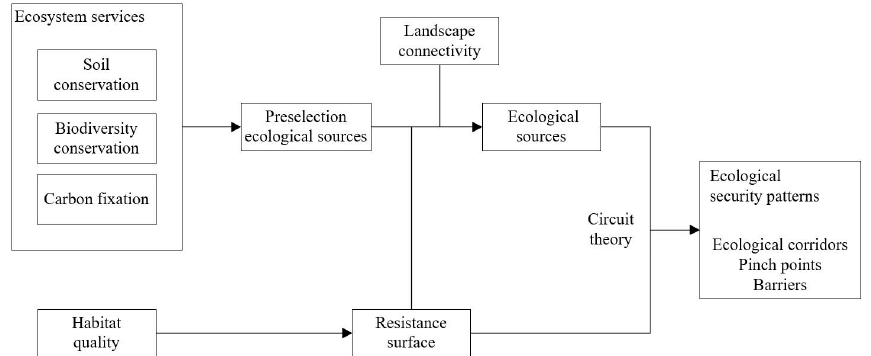
Figure 2. Framework for identifying ecological security patterns.